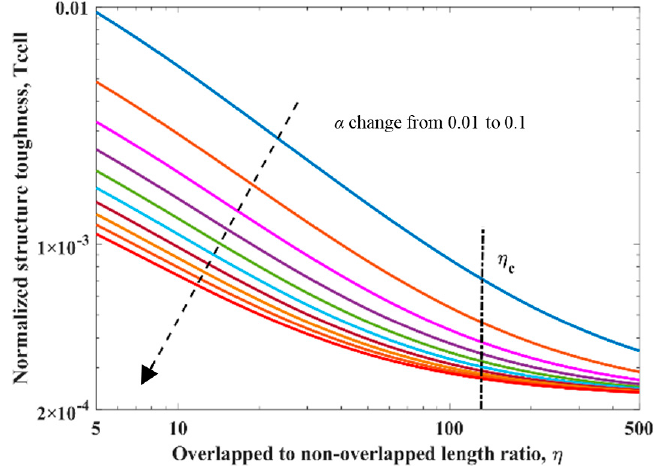
Figure 6. The structure toughness change with respct to the non-dimensional geometrical parameter η and the non-dimensional material parameter α , in the logarithmic coordinate. α changed from 0.01 to 0.1 discretely, shown with a black dashed line. η changed from 5 to 500 continuously, and the η c is marked with a black dash-dotted line. Other parameters used for making this figure were inherited from Table 1.